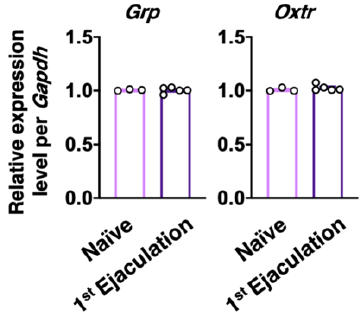
Figure 3. Effect of sexual experience on the Grp and Oxtr mRNA expression in the somal region of dXL neurons. No statistical difference was noted in the Grp and Oxtr mRNA expression between Naïve male rats ( n = 3) and 1st-Ejaculation male rats ( n = 5) (unpaired t -test, t 6 = 0.15 in Grp , t 6 = 0.93 in Oxtr ).